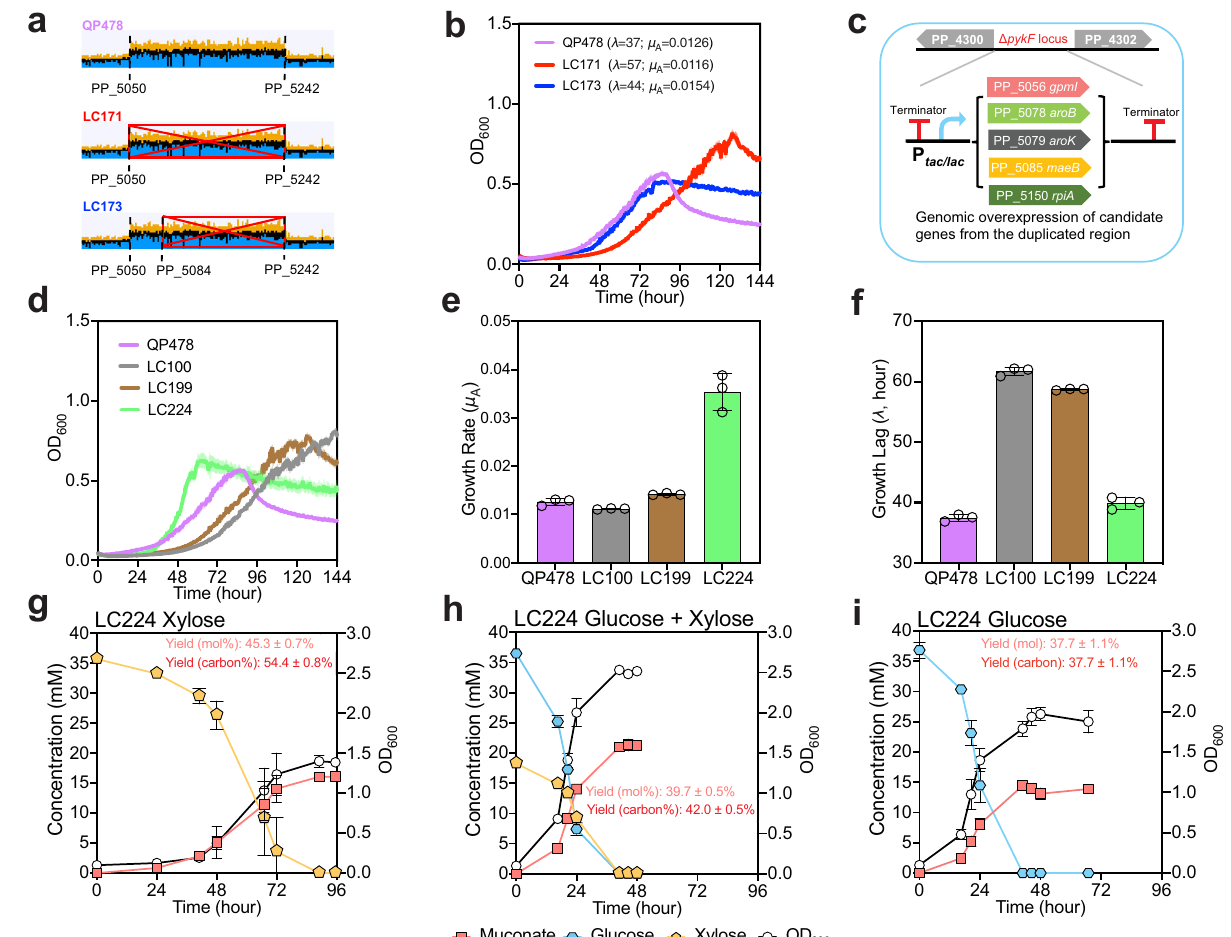
Fig. 4 | Characterizationofrationally engineeredstrains overexpressinggenes from the duplicated region. a Identi fi cation of the duplicated region from next- generation sequencing data,which presented ~2× the numberof sequencing reads in QP478, and complete and partial deletions of these duplicated regions in LC171 andLC173,respectively.ThegraphsofcoverageweregeneratedinGeneiousPrime 2020.0.4. b GrowthcurvesofQP478,LC171,andLC173onM9mediumwith30mM xylose. λ represents growth lag, μ A represents absolute growth rate, and both are the average values of three independent growth curves. c Overexpressing candi- dategenesinreverseengineeredstrainLC100atthe Δ pykF site. d Growthcurvesof